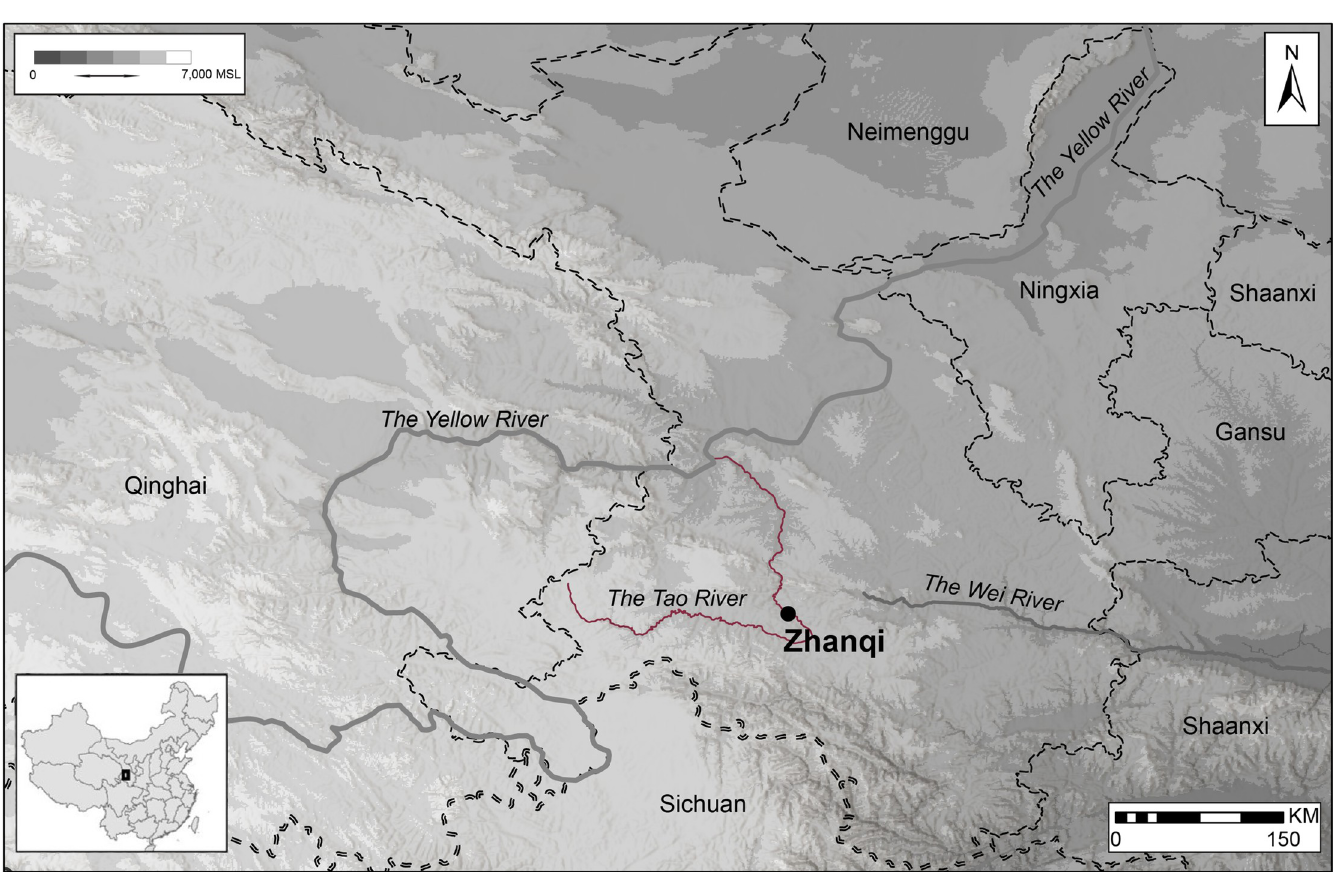
Fig 1. Location of the Zhanqi site. This map was made in ArcGIS software with original materials as well as open access files obtained from China historical GIS database at Harvard University—http://sites.fas.harvard.edu/~chgis/.